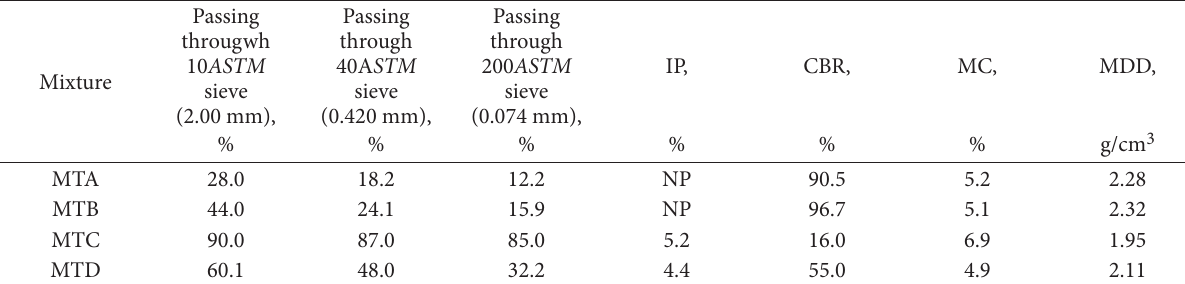
Table 6. Features of materials adopted in the assessment procedure